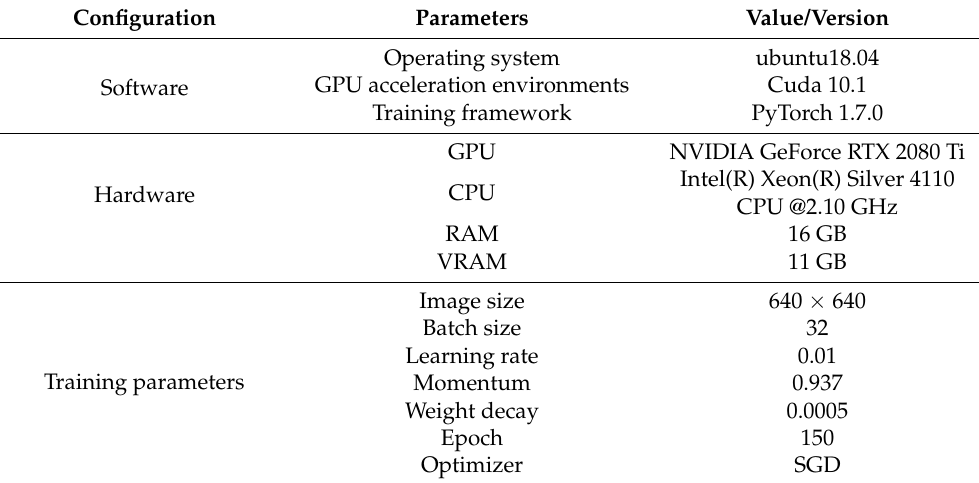
Table 2. Experimental environment configuration and training parameters.